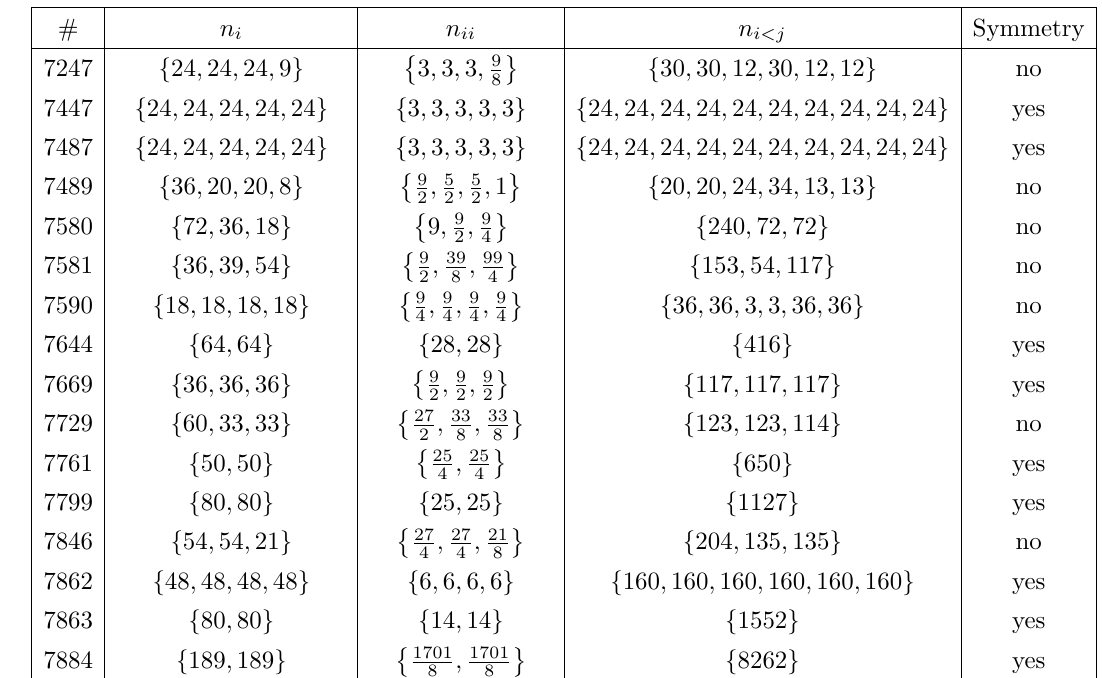
Table 9. Details of F inst (defined in eq. (2.6)) for all the 31 CYs which are relevant to examine the EFFV are presented, along with the presence of an underlying symmetry. The counting of n termines the h 1 , 1 for the corresponding CY. It is worth noticing that the first example has all the n being equal, while the symmetry does not hold for higher order GV dependent quantities, n Open